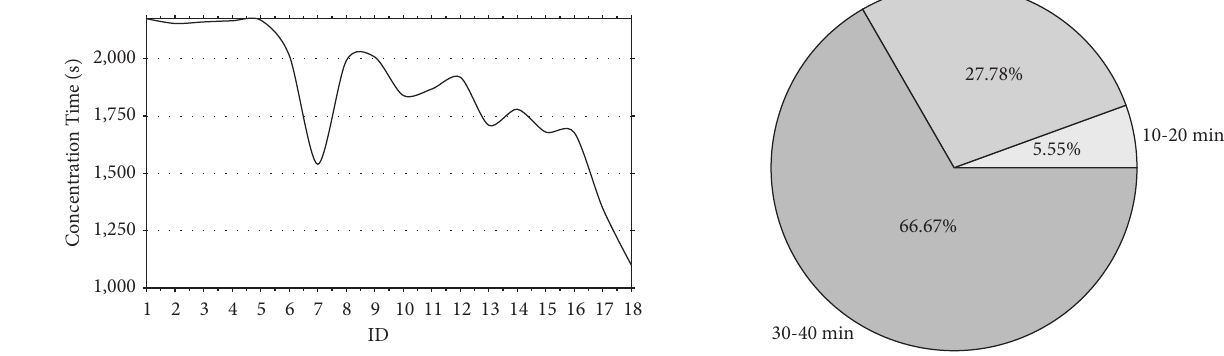
Figure 12: Concentrated duration report for all students. Figure 13: Concentration duration statistic